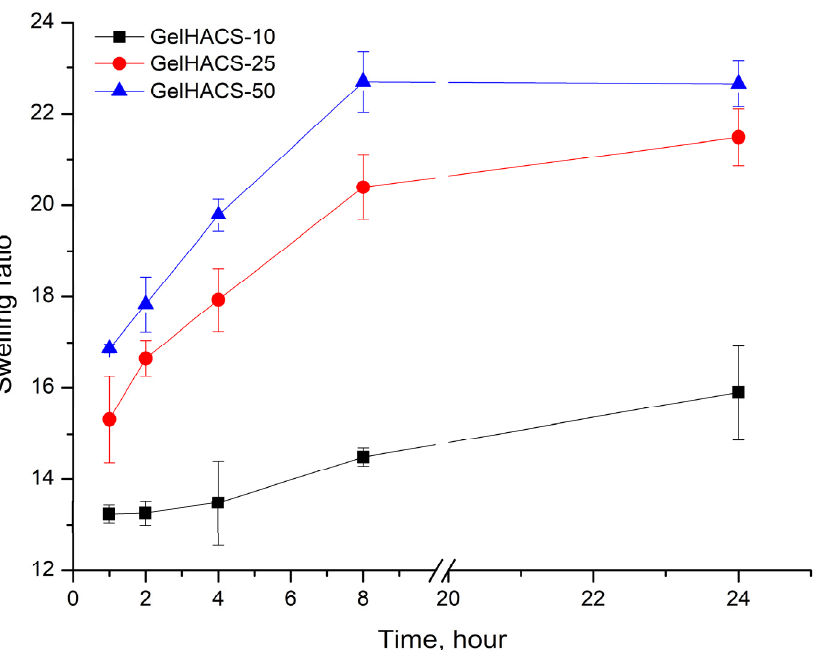
Figure 4. Dependence of the swelling ratio of the cryogels in PBS on the time of swelling. The degradation of biomaterials is critical for both drug delivery and tissue engineer- ing, as implanted biomaterial must avoid chronic inflammation, fibrous encapsulation and implant rejection during implantation [26]. During degradation, the process of hydrolysis occurs, which destroys the walls of macropores of cryogels, thereby causing a loss in mass. When studying the degradation of GelHACS-10, GelHACS-25 and GelHACS-50 cryogels in PBS at 37 ◦ C, weight loss was observed over time (Figure 5). In 8 weeks, 27.1 ±